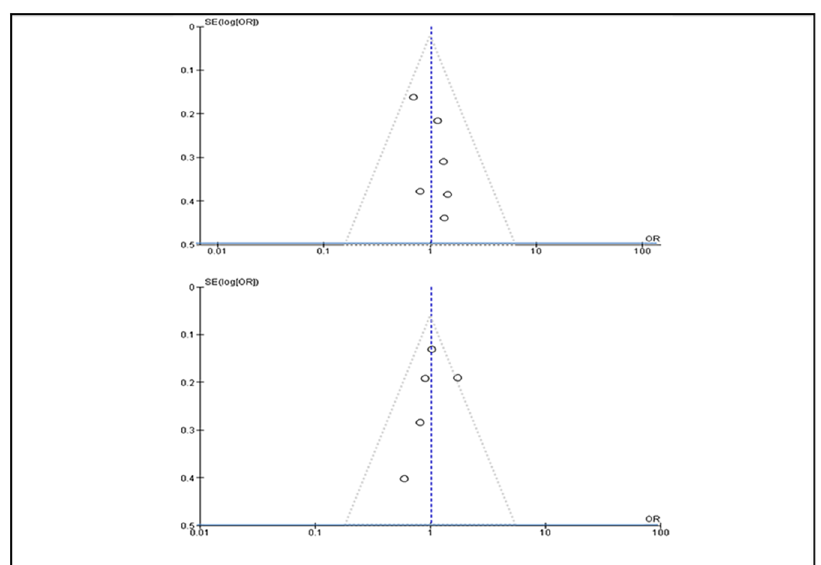
Fig 4. Funnel plot of MACE at 1 year and long term